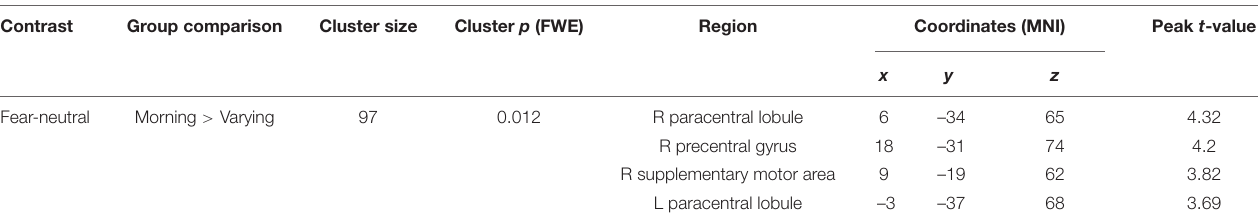
TABLE 5 | Brain regions with nominally significantly increased activation responding to fearful faces: Morning start > Varying start (Study